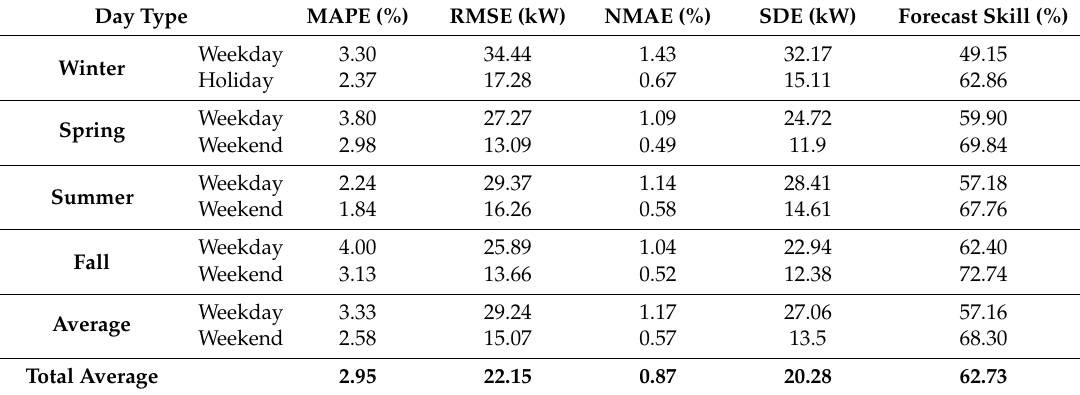
Table 3. Forecasting performance analysis of the proposed model (WT-SA-FFANN).